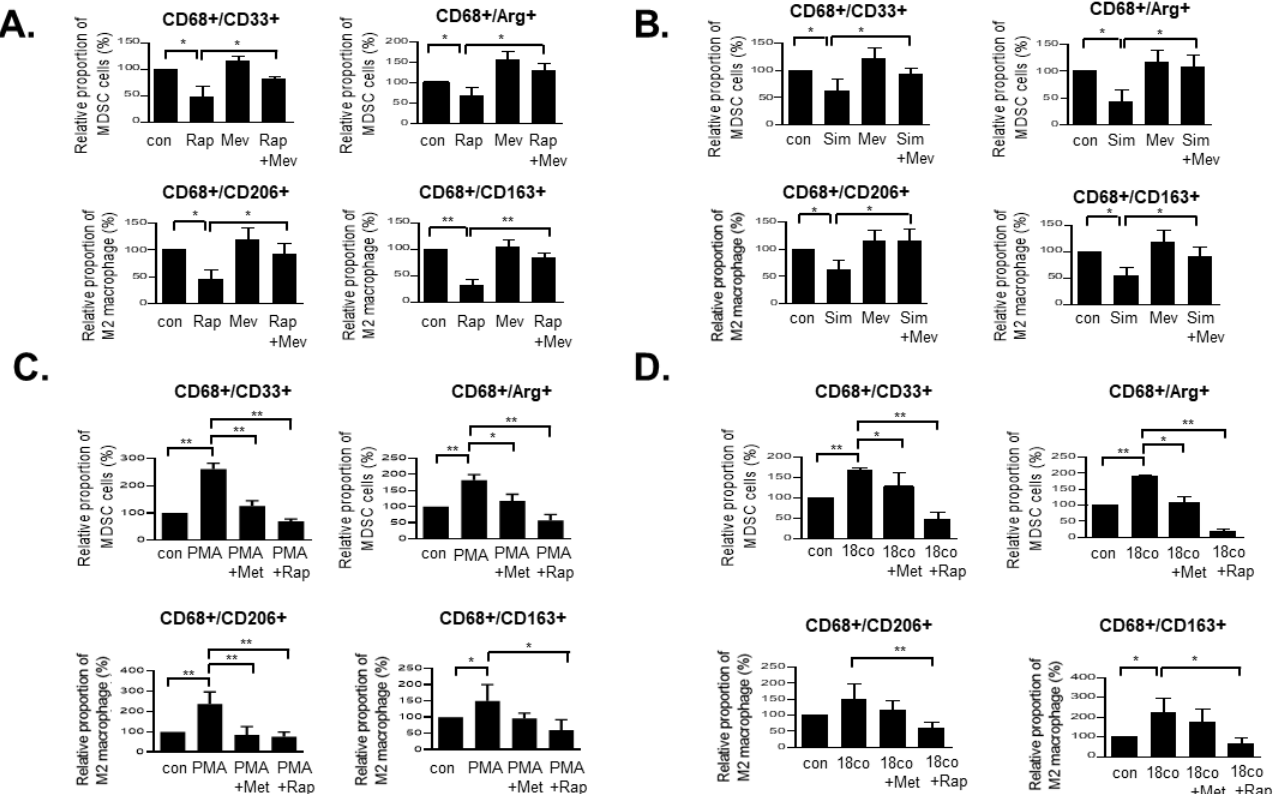
Figure 2. Rapamycin and simvastatin decrease the fractions of MDSCs and M2 macrophages, an effect that is reversed by mevalonate treatment . ( A ) Rapamycin (20 nM) and ( B ) simvastatin (2 μM) with or without 200 μM mevalonate were used to treat THP -1 cells for 48 h. Next, the expression levels of MDSC (CD33 + /CD68 + and Arg-1 + /CD68 + ) and M2 macrophage (CD206 + /CD68 + and CD163 + /CD68 + ) markers were analyzed by flow cytometry. D ata are expressed as the means ± standard errors of the three different experiments; * p < 0.05, ** p < 0.005. THP-1 cells were pre-treated with 100 nM PMA for 6 h. ( C ) and then were treated with or without 2 mM metformin or 20 nM rapamycin for 48 h. 18Co Cells were grown in serum-supplemented culture media, washed with PBS and starved overnight in serum-free media. After 2 days, this medium was harvested, and THP-1 cells were grown in 18Co CM and treated with or without 2 mM metformin or 20 nM rapamycin for 48 h. ( D ) Next, the expression levels of MDSC (CD33 + /CD68 + and Arg-1 + /CD68 + ) and M2 macrophage (CD206 + /CD68 + and CD163 + /CD68 + ) markers were analyzed by flow cytometry analysis. D ata are expressed as the means ± standard errors of the three different experiments ; * p < 0.05, ** p < 0.005.